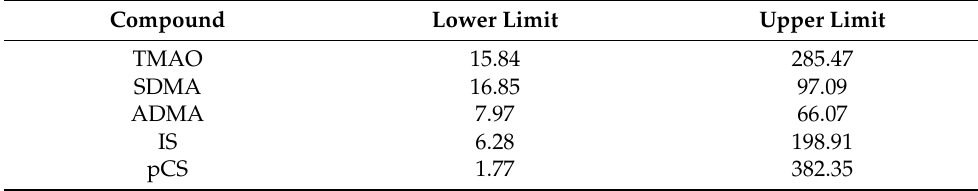
Table 2. Nonparametric percentile method (CLSI